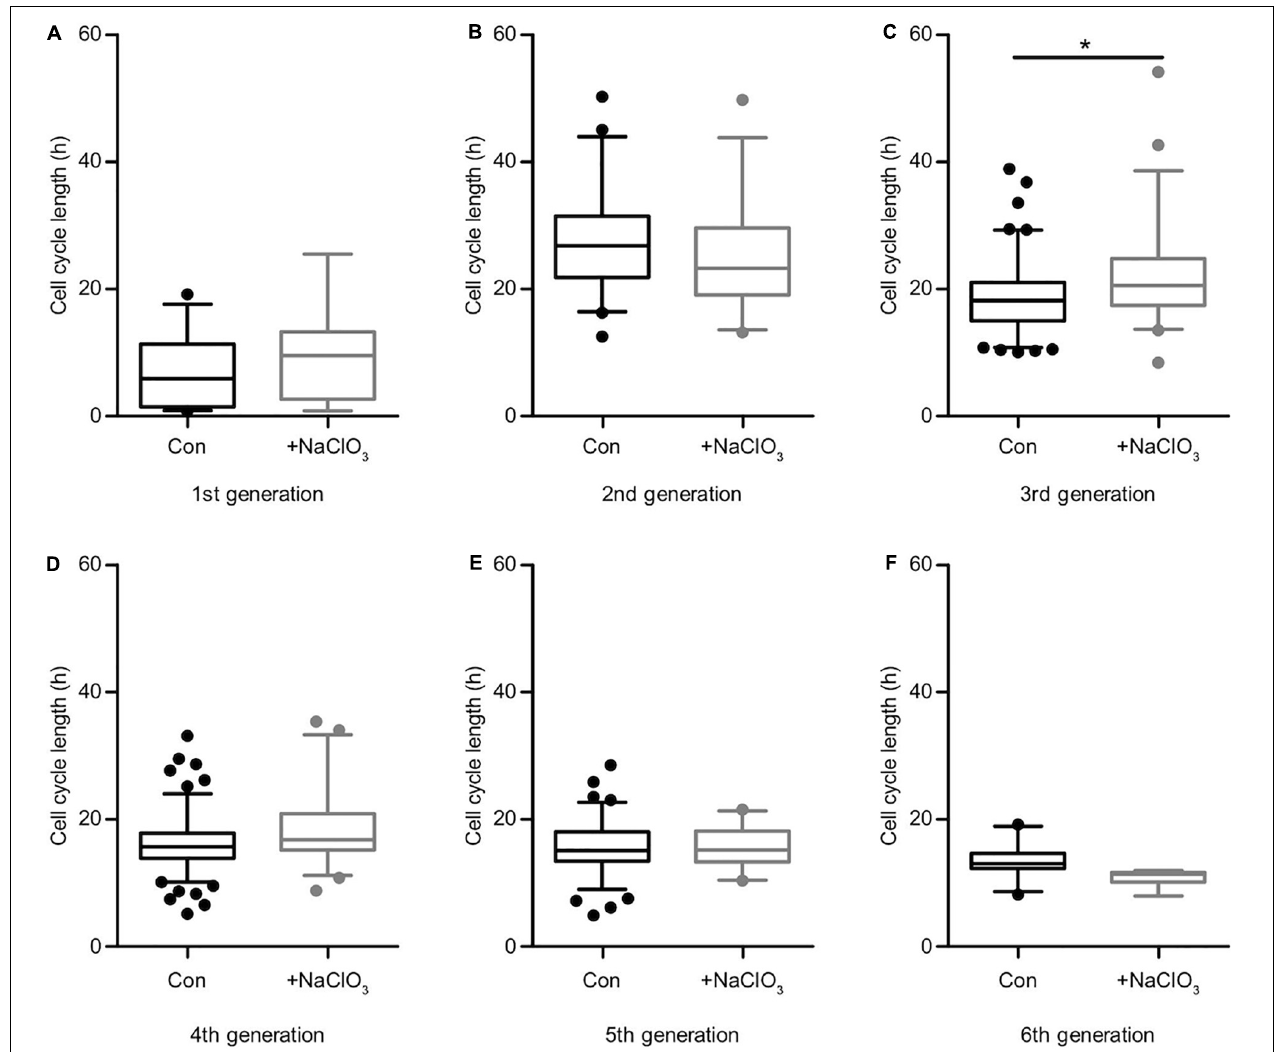
FIGURE 6 | Sulfation of spinal cord progenitors had a minor influence on the cell cycle in the presence of EGF. The cell cycle lengths of control (black boxes) and chlorate-treated (gray boxes) spinal cord progenitors cultivated in the presence of EGF are shown for the first (A) , second (B) , third (C) , fourth (D) , fifth (E) and the sixth generation (F) . In the third generation (C) the inhibition of sulfation led to a slightly slower cell division compared to untreated cells. In all other generations, the suppression of sulfation had no significant influence on the cell cycle length. * p ≤ 0.05 (Mann-Whitney U -test); control: N = 4; chlorate: N =